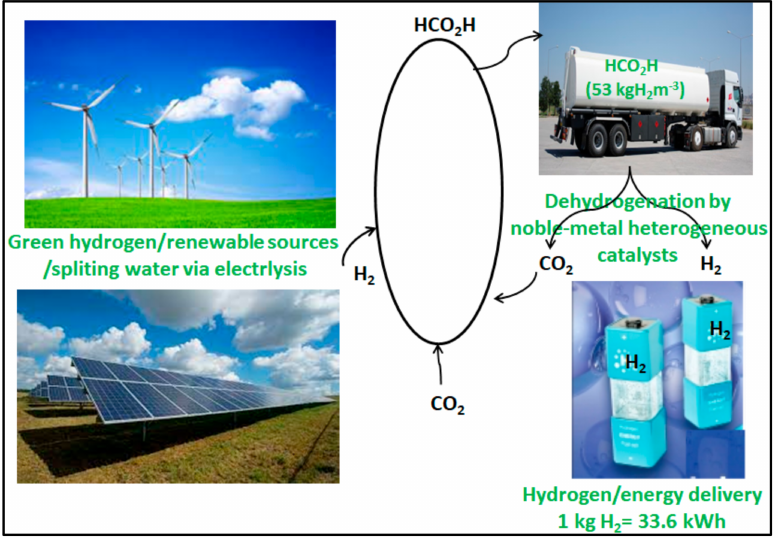
Figure 2. Carbon neutral energy storage via formic acid as a hydrogen carrier